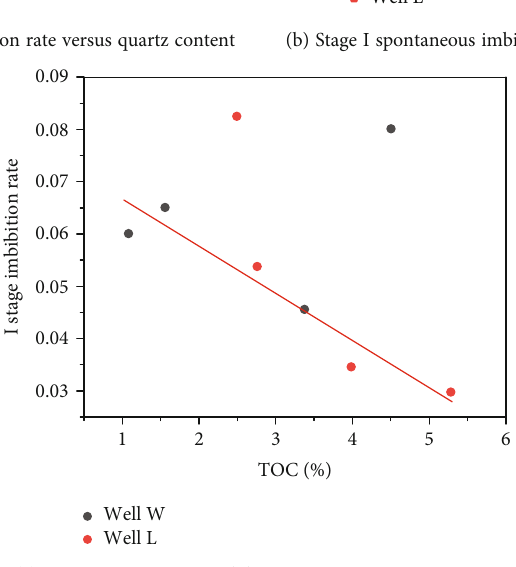
(a) Stage I spontaneous imbibition rate versus quartz content (b) Stage I spontaneous imbibition rate versus clay content